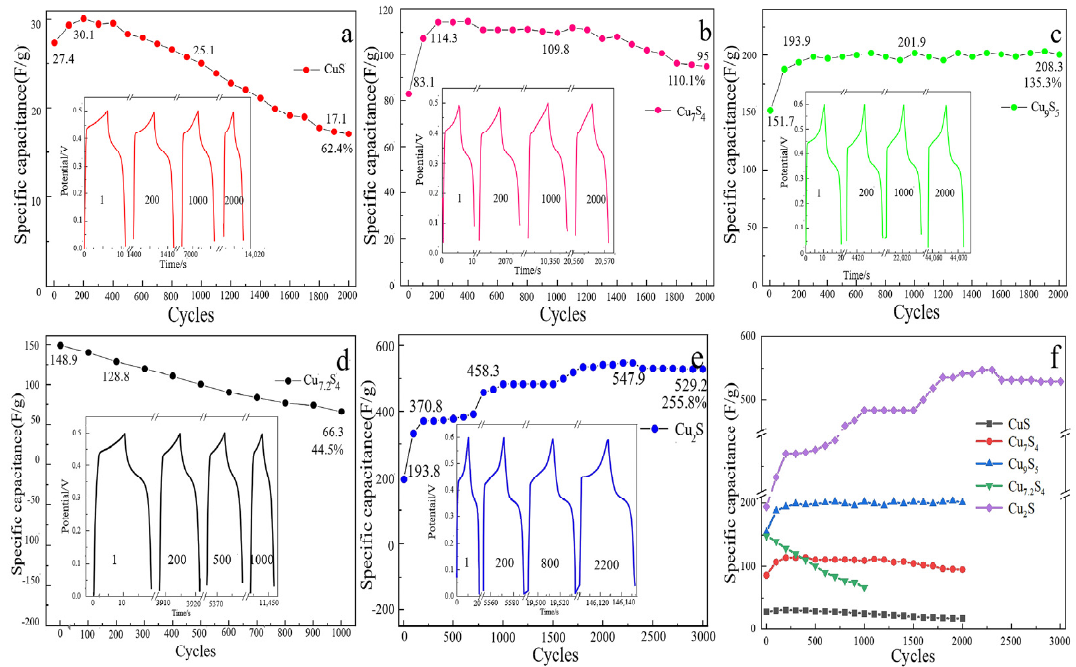
Figure 5. ( a ) to ( e ) are different cyclic properties of copper sulfides at 10 A/g current density: CuS ( a ), Cu 7 S 4 ( b ), Cu 9 S 5 ( c ), Cu 7.2 S 4 ( d ), Cu 2 S ( e ); a synthetic contrast of cyclic properties of ( f ) five kinds of copper sulfides.